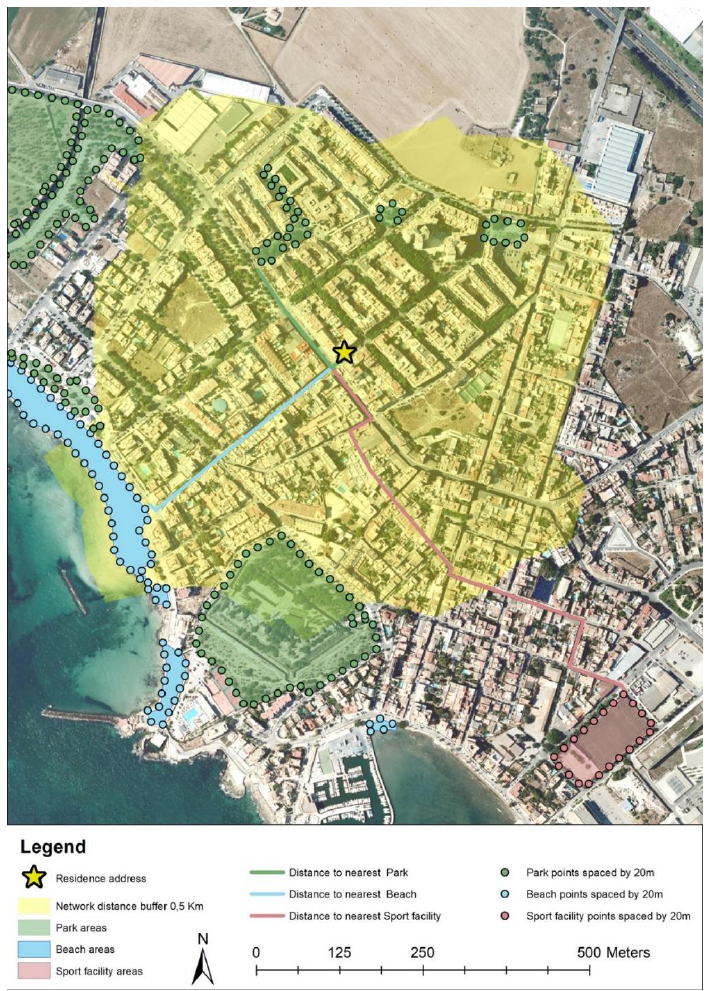
Figure 2. Example of exposure to public open spaces (POS). A 0.5 km network walkable street buffer around of the residence address represented by the yellow area.